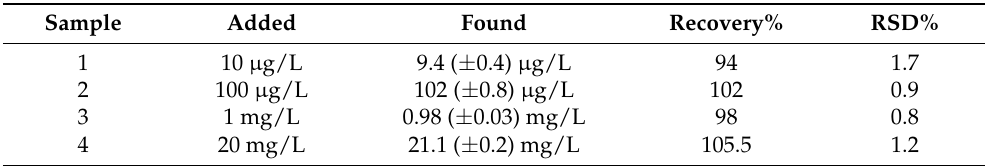
Table 2. Difference between spiked alprazolam solution in serum and the actual amount with recovery and respective RSD